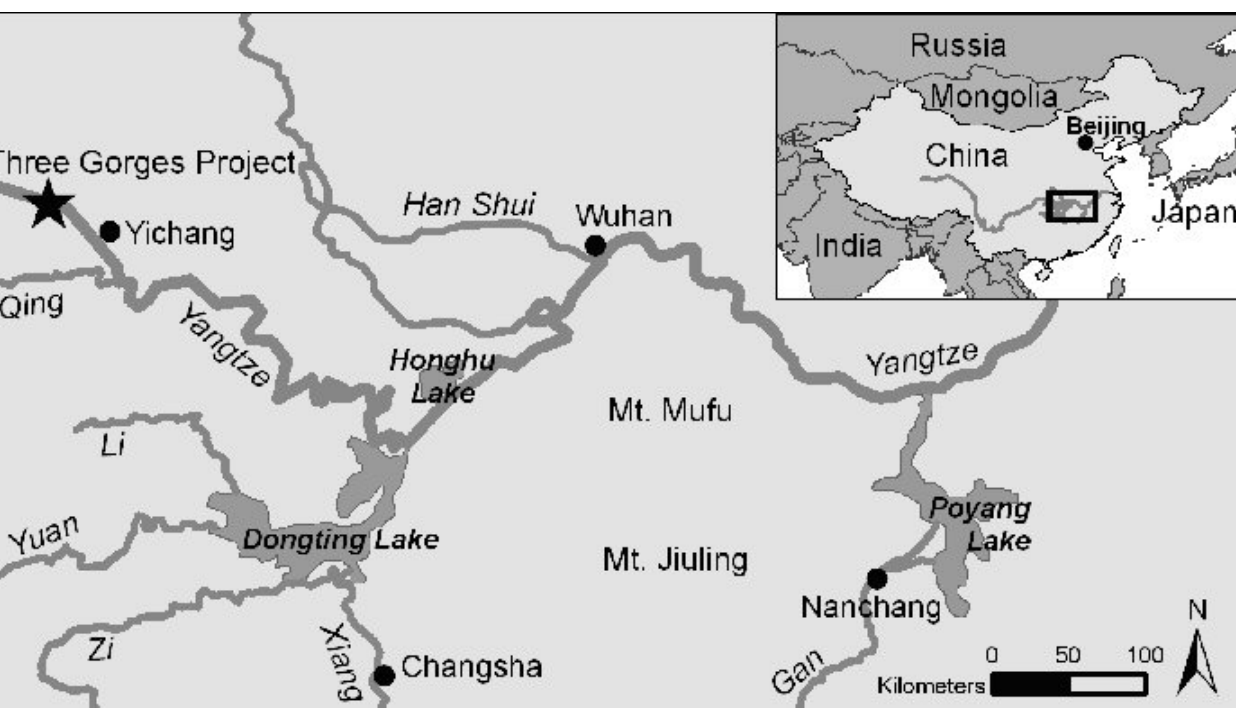
Fig. 1 . China and the Yangtze River basin, including Poyang Lake and Dongting